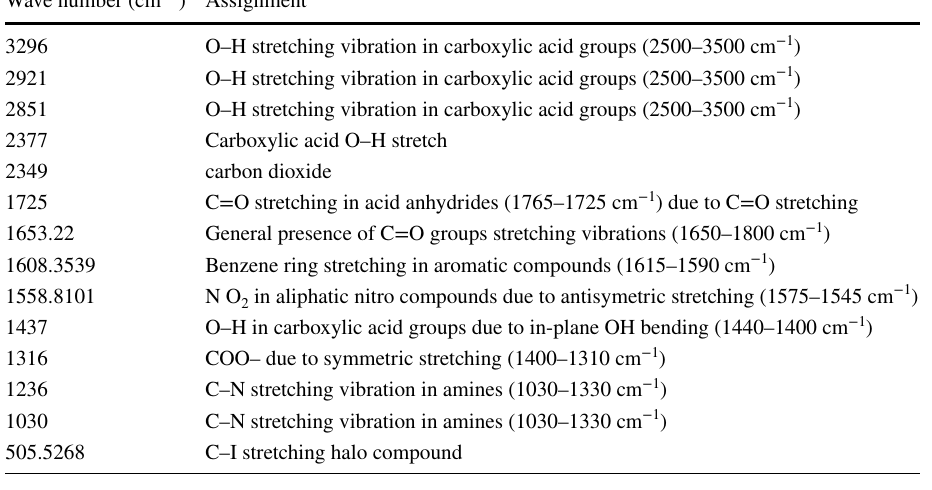
Fig. 4 FTIR-spectral analysis of Neem leaf powder having the amines vibration at the high frequency region of the absorp- tion band which is suitable for the adsorption kinetics